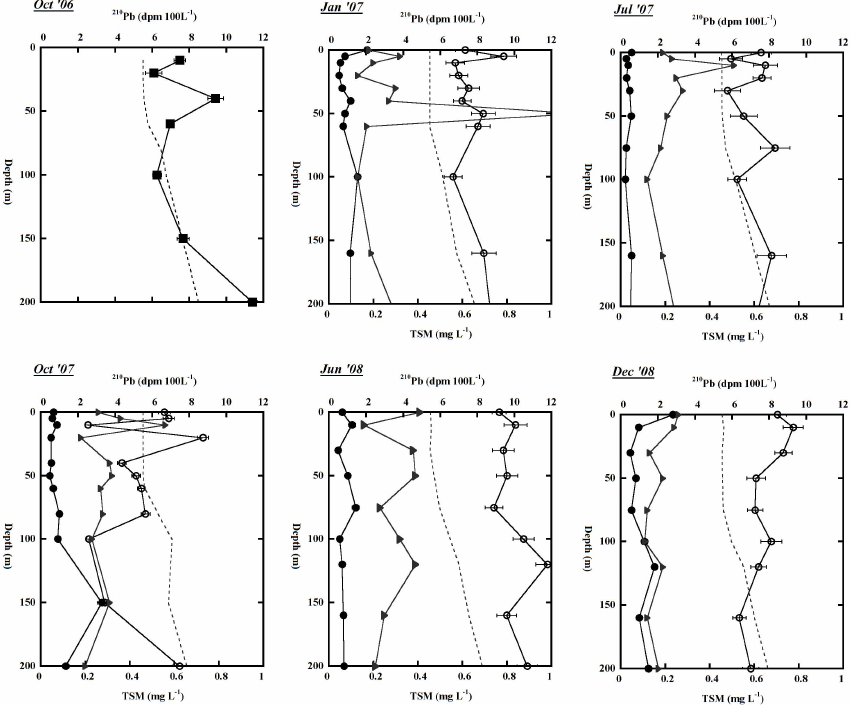
Fig. 3. Vertical distributions of dissolved (open square) and particulate (solid square) 210 Pb, TSM concentration (solid circle), and the 226 Ra (thick dotted line) estimated from SiO 2 (Nozaki and Yamamoto, 2001). Note only total 210 Pb (solid triangle) is available for ORI-821 (October 2006). Error bars represent uncertainty based on propagated counting errors ( ± 1 σ